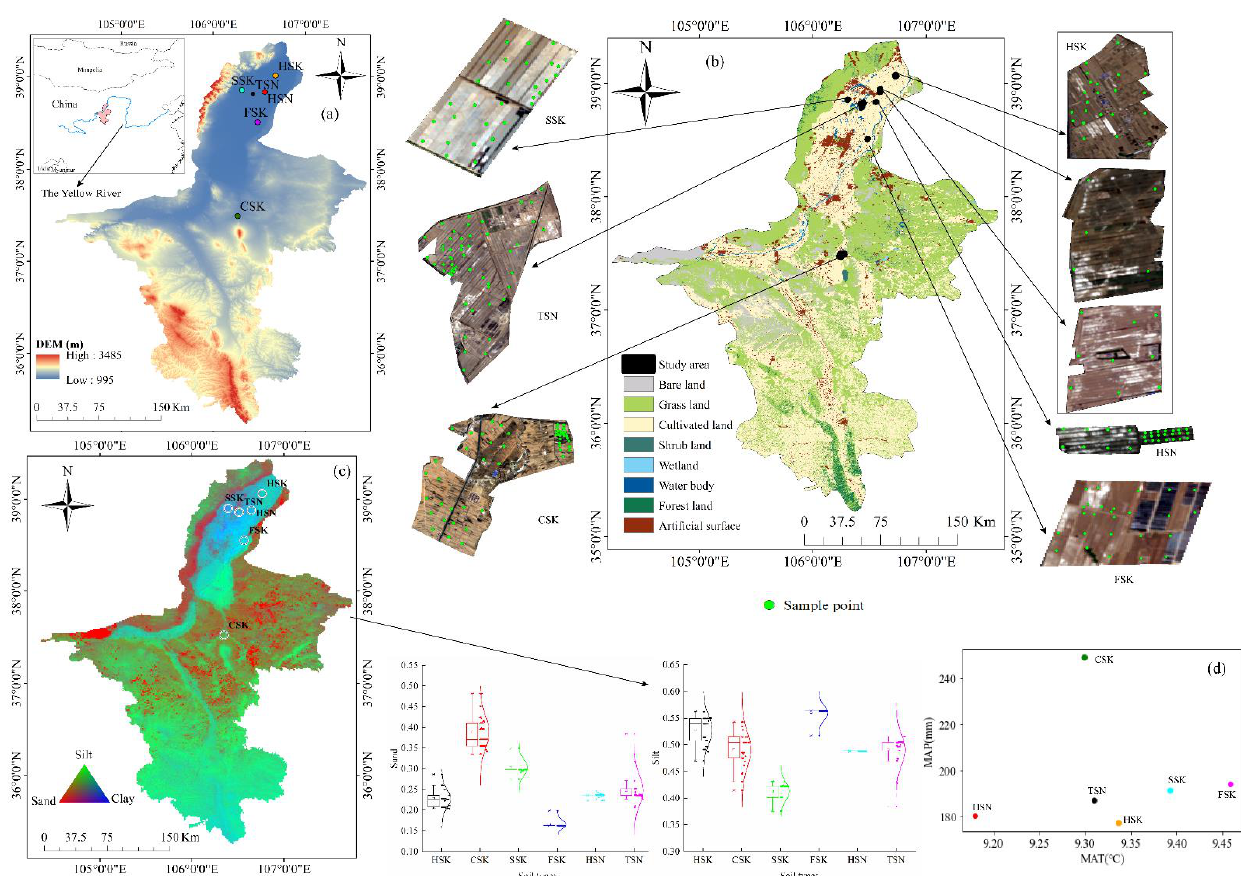
Figure 1. Location of the sampling sites in the study area. ( a ) Digital elevation model (DEM) of Ningxia autonomous in China; ( b ) distribution of sampling points; ( c ) variations in soil textures in the study area; ( d ) mean annual precipitation (MAP) and mean annual temperature (MAT) of the sampling sites. HSK is Haplic Solonchaks, SSK is Stagnic Solonchaks, CSK is Calcic Sonlonchaks, FSK is Fluvic Solonchaks, HSN is Haplic Sonlontzs, and TSN is Takyr Solonetzs.